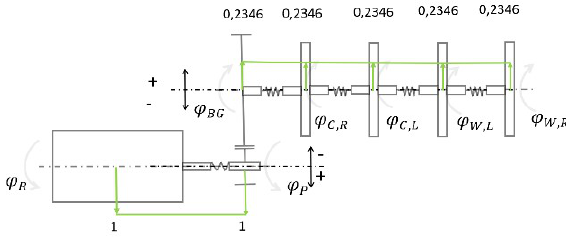
Figure 10. First natural mode of torsion oscilla- tions [3].